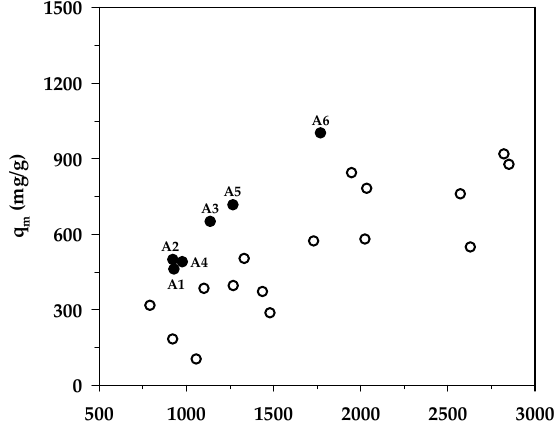
Figure 8. Effect of BET surface area on the maximum MB adsorption capacity. The black circles represent results from the present study (A1–A6), whereas the white circles represent those from previous works.